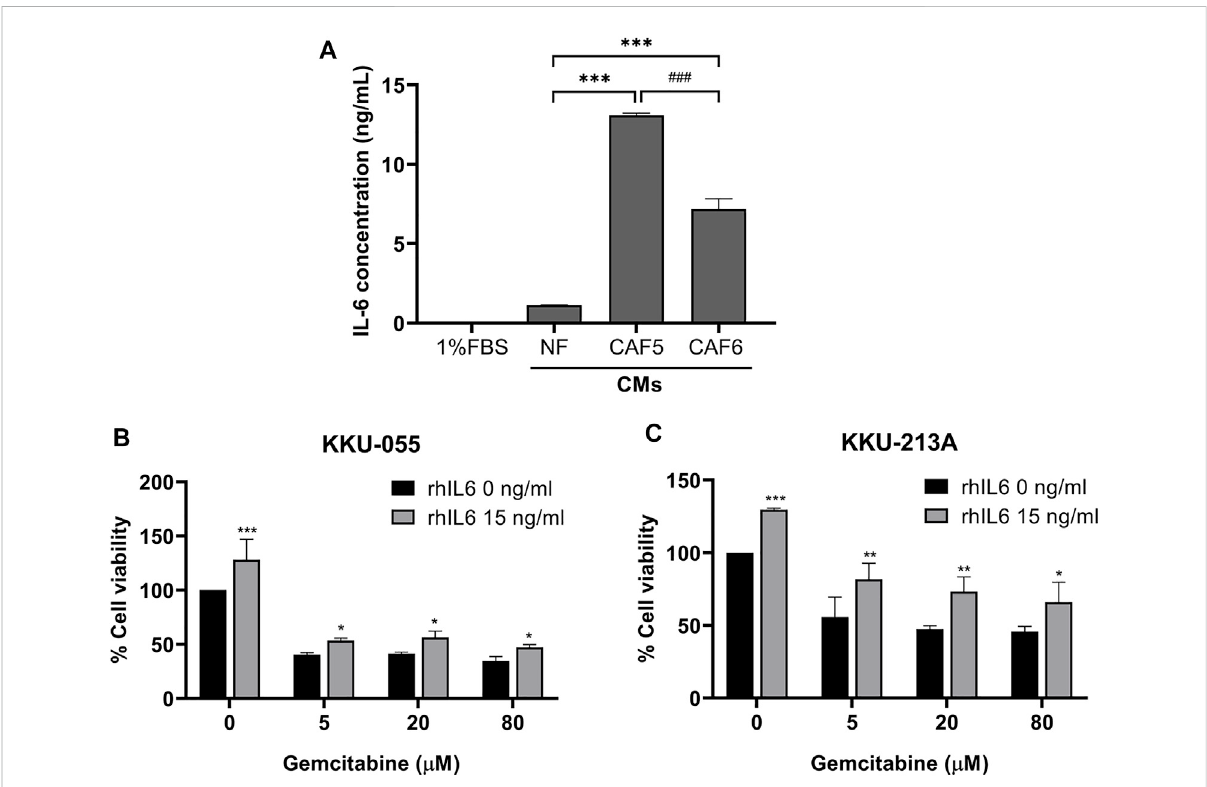
FIGURE 2 The level of IL-6 secreted from NF, CAFs and ef fi cacy of rhIL-6 on gemcitabine response of CCA cells. (A) A human IL-6 ELISA kit was used for analyzingthelevelofIL-6inconditionedmedium(CMs)fromNFandCAFs. (B,C) CellviabilitywasmeasuredinCCAcells(KKU-055andKKU-213A)by MTT assay upon treatment with rhIL-6 and gemcitabine. Error bars represent the standard deviation (SD) of triplicate experiments. A signi fi cant difference was determined using ANOVA and unpaired t-test (* p < 0.05, ** p < 0.01, *** p < 0.001 compared to the control groups, ### p < 0.001 compared between CAF5 and